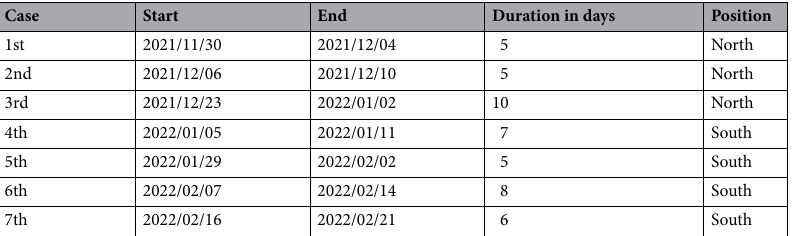
Table 1. Oceanic South Atlantic Convergence Zone (SACZ) characteristics. The first column is the case number, and the second and third columns are the start and end date of cases. The fourth column is the oceanic SACZ length in days The last column indicates the SACZ